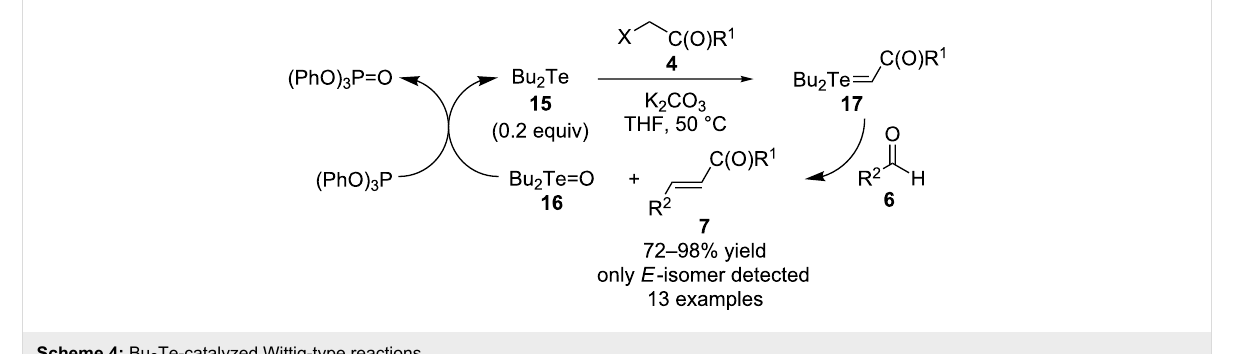
At about the time that Huang and co-workers reported their cat- alytic reactions using 3 (Scheme 2), they also disclosed that Bu 2 Te ( 15 ) could function similarly as a catalyst in such Wittig- type reactions due to the relatively weak tellurium–oxygen bond of dialkyl telluroxides, such as Bu 2 Te=O ( 16 ) (Scheme 4) [13]. Aldehydes 6 were again used as substrates in reactions to form products 7 . No comments were made regarding the relative advantages or disadvantages of using either 3 or 15 as the cata- used to generate ylides 16 as were used in the reactions cata- lyzed by 3 . The only notable differences regarding performing the reactions were that reactions with 15 required a higher tem- perature (50 °C compared to room temperature) and aceto- nitrile as a co-solvent. However, product yields and stereoselec- tivities were slightly improved when 15 was used at the same loading level (0.2 equivalents) and with a similar set of alde- hyde 6